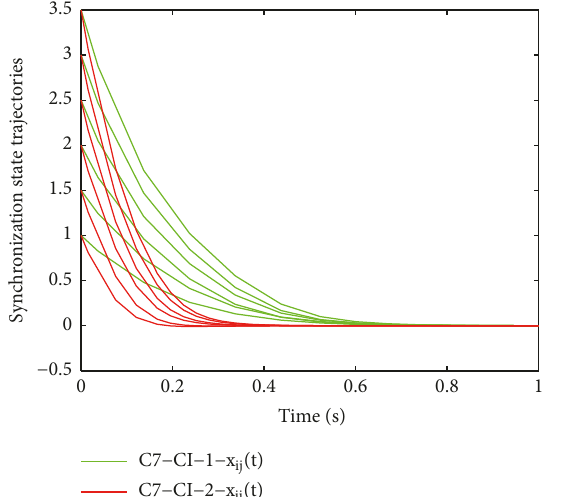
Figure 9: Synchronization state trajectories of the network (36) for the case I-1 and I-2 of Corollary 27.